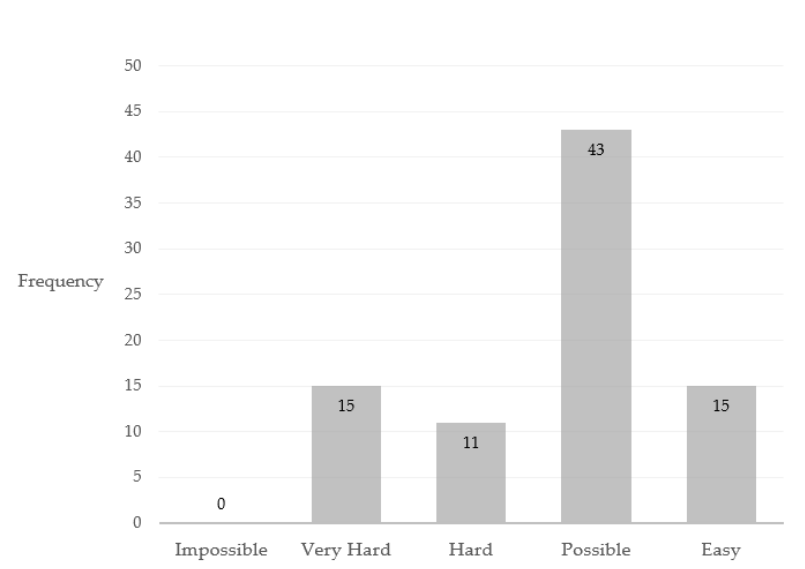
Figure 1. Reported difficulty in taking intraoral photos by study subjects.